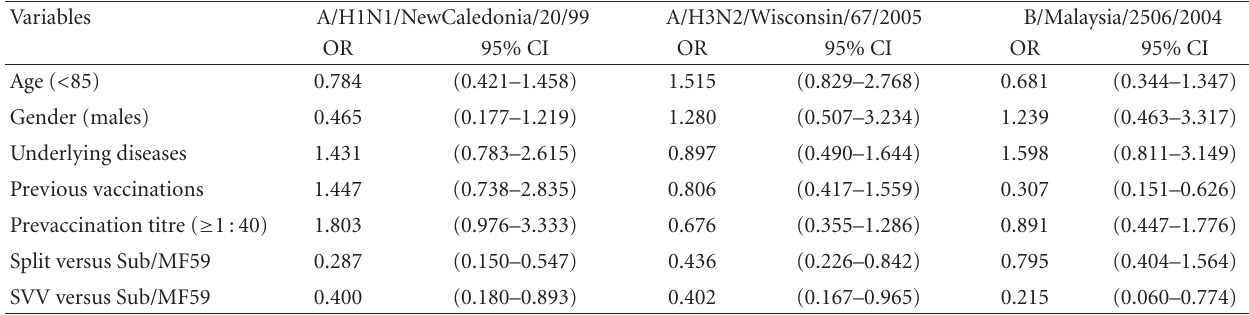
Table 3: Multivariate analysis of variables associated with 4-fold HI-antibody titer increases according to heterologous virus strains.